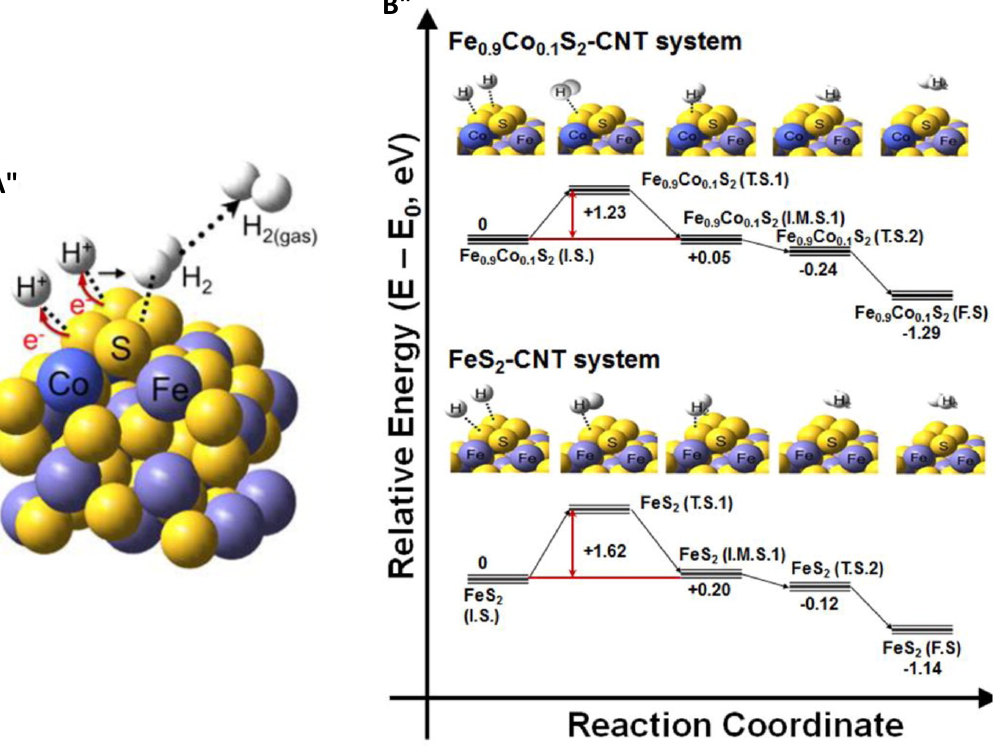
Figure 7. ( A ) Schematic reaction of hydrogen evolution occurring on a sulfur atom of Fe 0.9 Co 0.1 S 2 . ( B ) Kinetic energy barrier profiles of HER on Fe 0.9 Co 0.1 S 2 -CNT (top) and FeS 2 -CNT (bottom) catalysts. Reprinted with permission from reference [81].